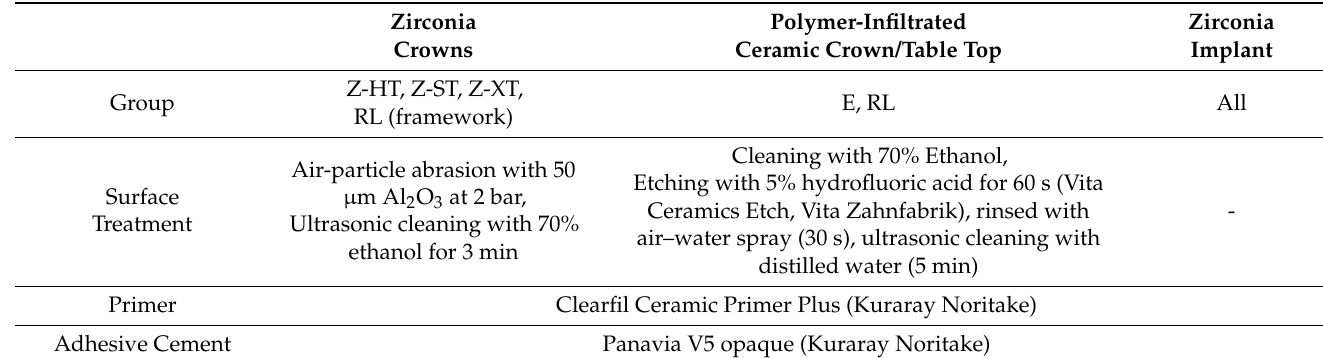
Table 2. Pretreatment and adhesive cementation of tested